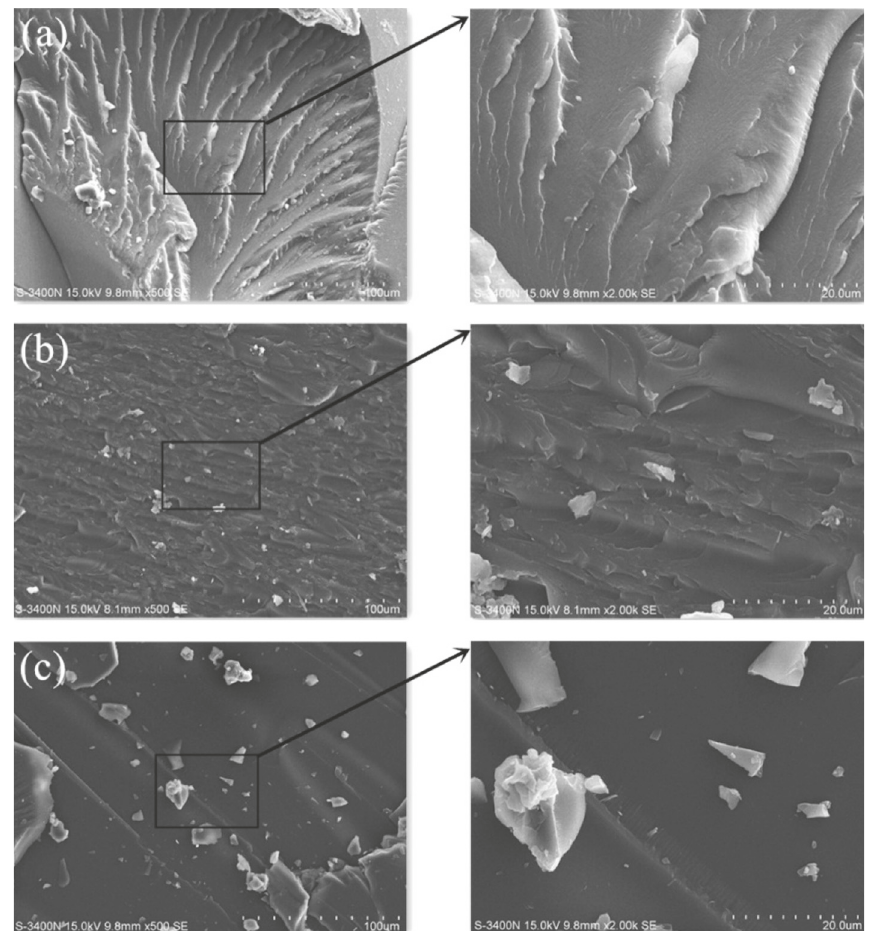
Figure 5: Microscopic fracture morphology of transparent hard rock-like materials. (a) Without RSS. (b) With 6% RSS. (c) With 10%